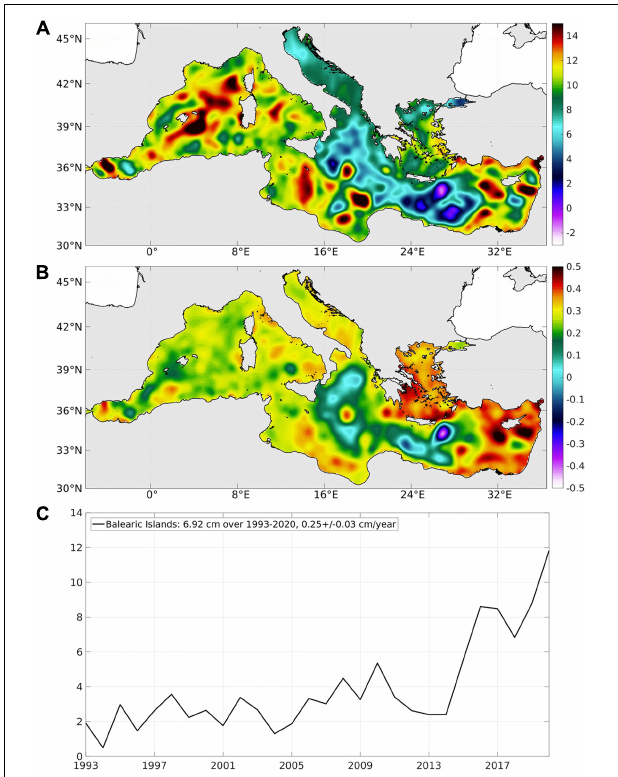
FIGURE 6 | Illustrations for annual mean SLA (in m): 2D maps of mean in 2020 (A) and linear trend over 1993–2020 (B) , and time series of SLA averaged in the Balearic Islands since 1993 (C)